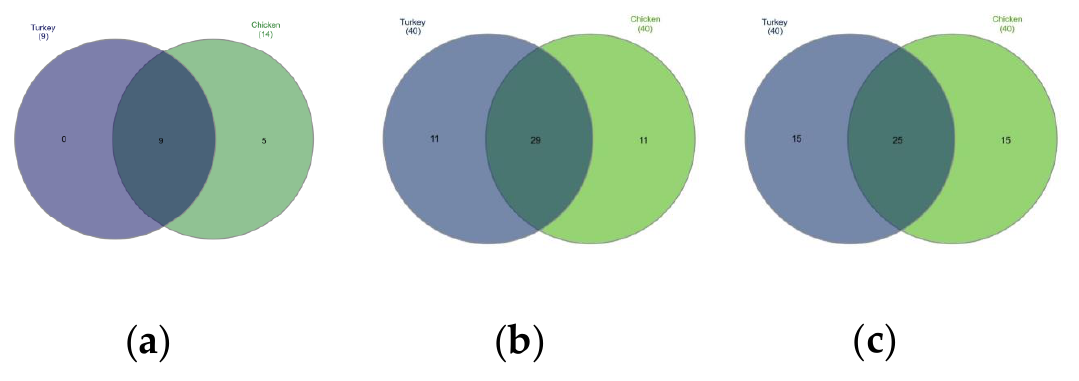
Figure 4. Venn diagrams showing shared taxa among the 40 most common at the: ( a ) phyla level, ( b ) family level, and ( c ) genus level.